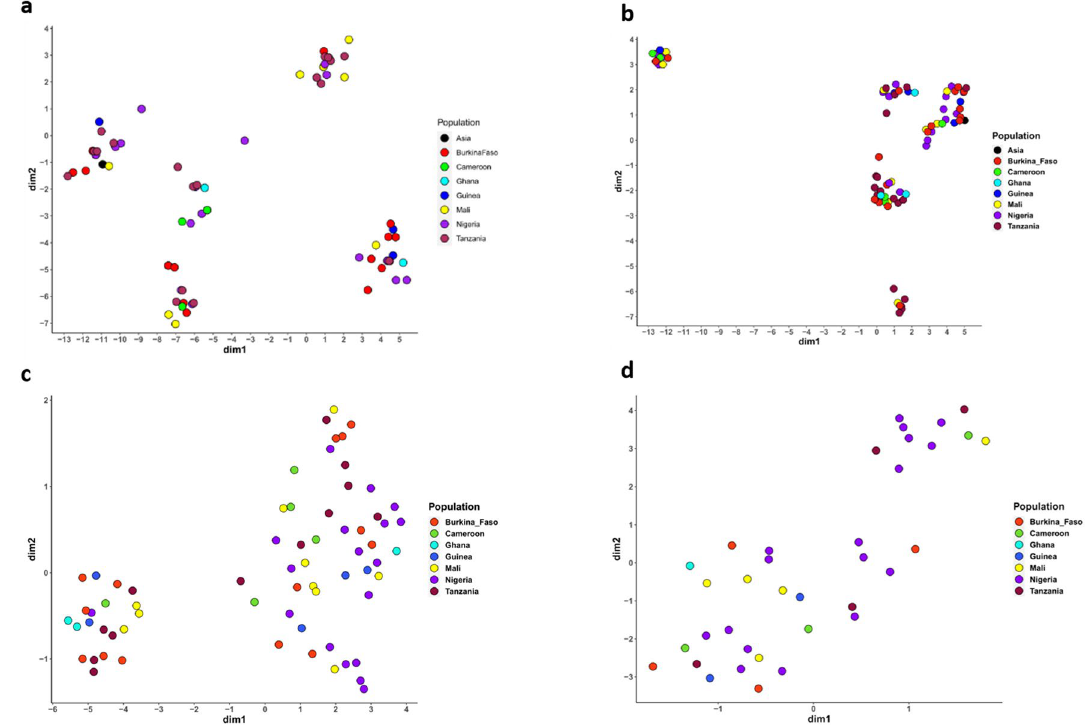
Figure 3. Discriminant analysis of principal component (DAPC) scatter display of population clusters of P. malariae isolates by ( a ) microsatellites, ( b ) SNP unfiltered, ( c ) SNP filtered for missingness only and ( d ) SNP denoised and filtered.